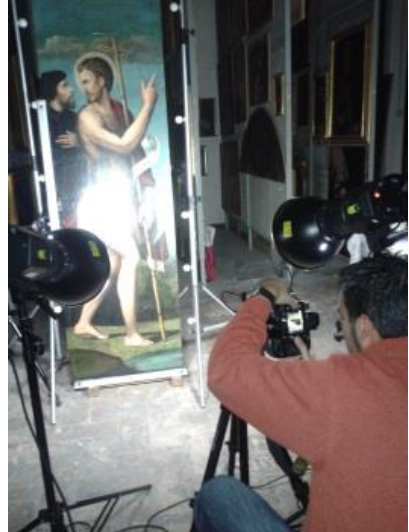
Figure 3. Photographic setup for the Saint John the Baptist painting with two lights symmetrically on the sides of the camera. This step is mandatory if reliable results are expected and to avoid a degradation of object points precision (Fraser, 1982; Kraus, 1997; Nocerino, 2013, 2014). In all the photogrammetric projects, two scale bars in horizontal and vertical positions were placed at the bottom and aside the painting. The paintings were properly lighted up using two calibrated photographic lamps.